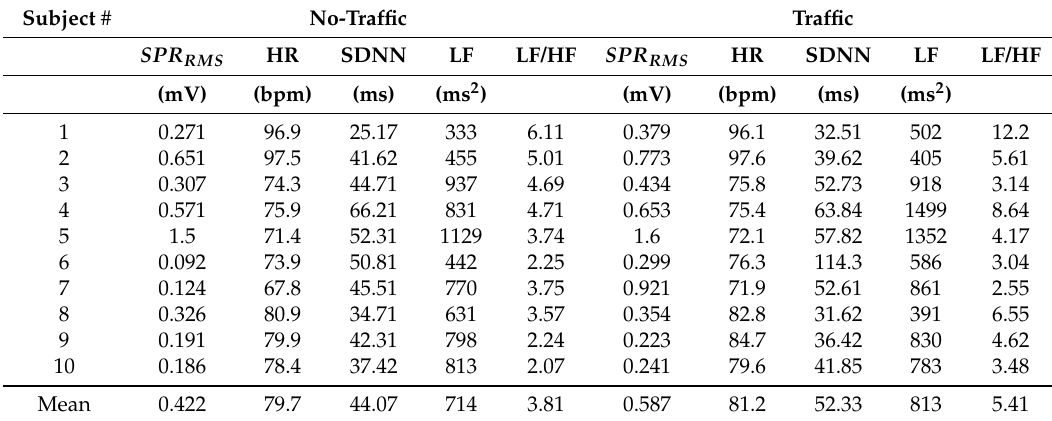
Table 3. Comparison between SPR and HRV features extracted in no-traffic or traffic